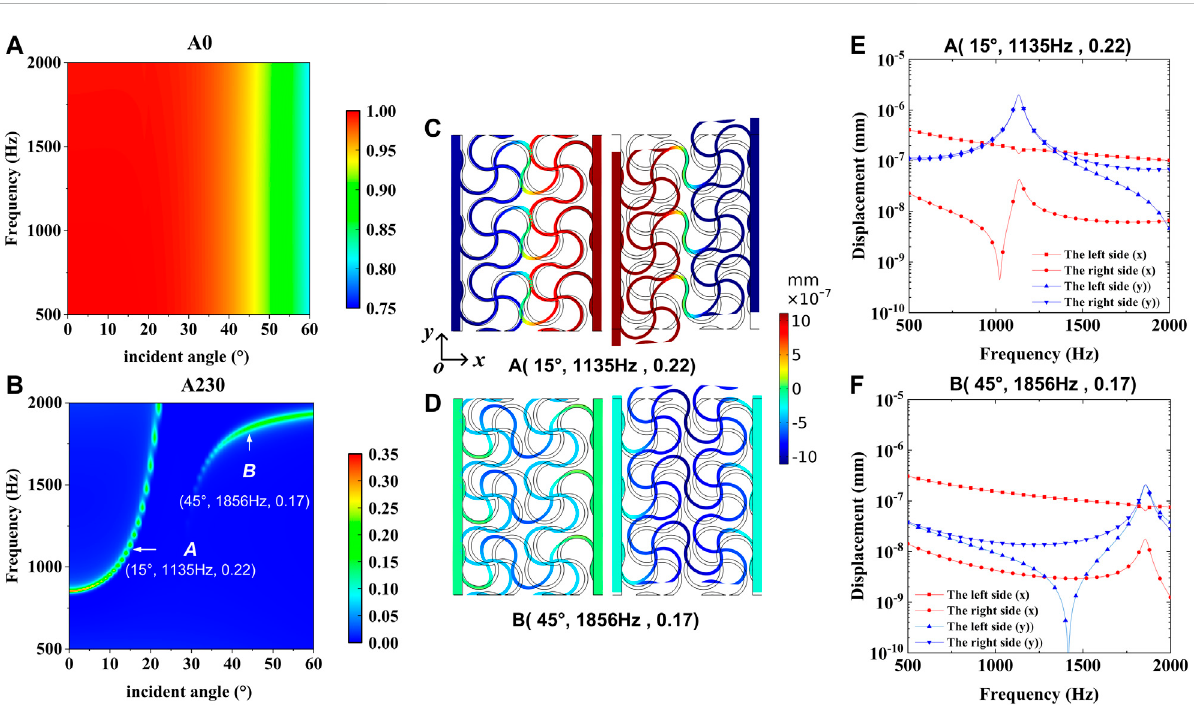
FIGURE 6 (A,B) are theacoustic transmission coef fi cients for metascreens A0 and A230, respectively, versusthe incidence angle and frequency. (C,D) are the displacement fi elds at the transmission peak frequency points of A230 at 15 ° and 45 ° incidence angles, respectively. (E) and (F) show the average absolute displacement of A230 in the x and y components at 15 ° and 45 ° incidence angles,